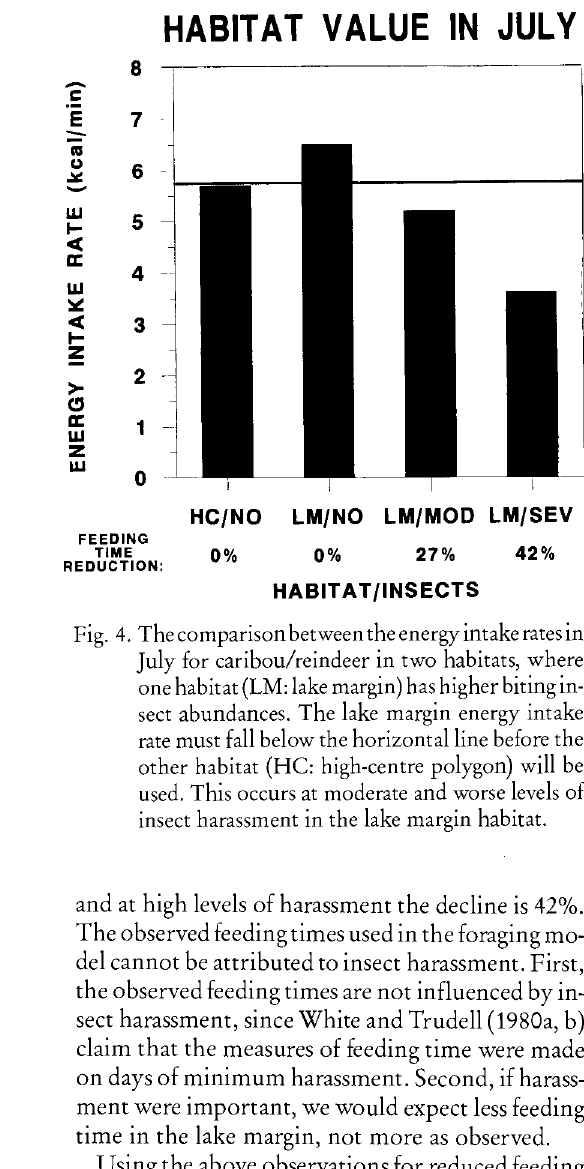
than in the lake margin habitat (Fig. 3).